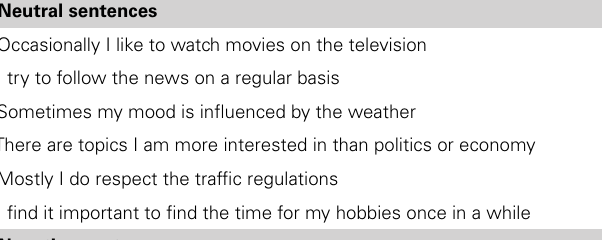
Table 1 | List of